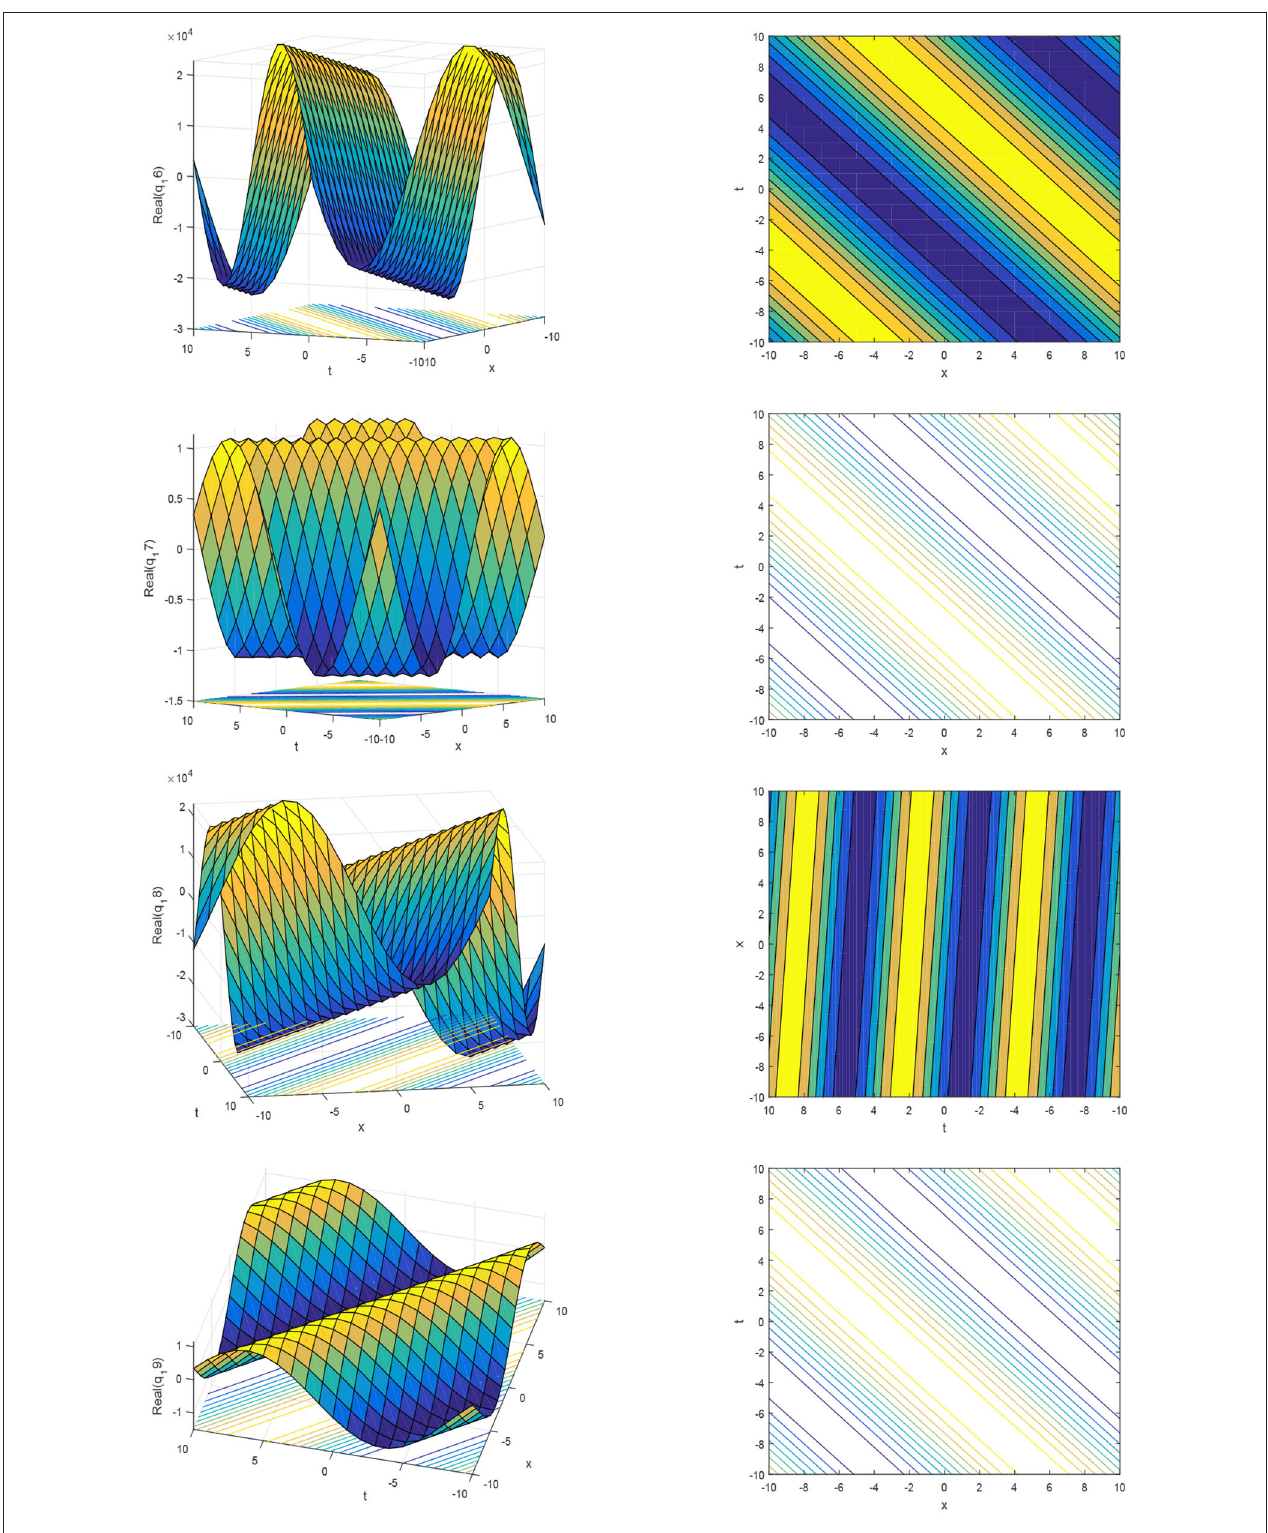
FIGURE 4 | The 3D plots and contourplots of the real part of solution q 16 ( x , t ) to q 19 ( x , t ), for different parameters.